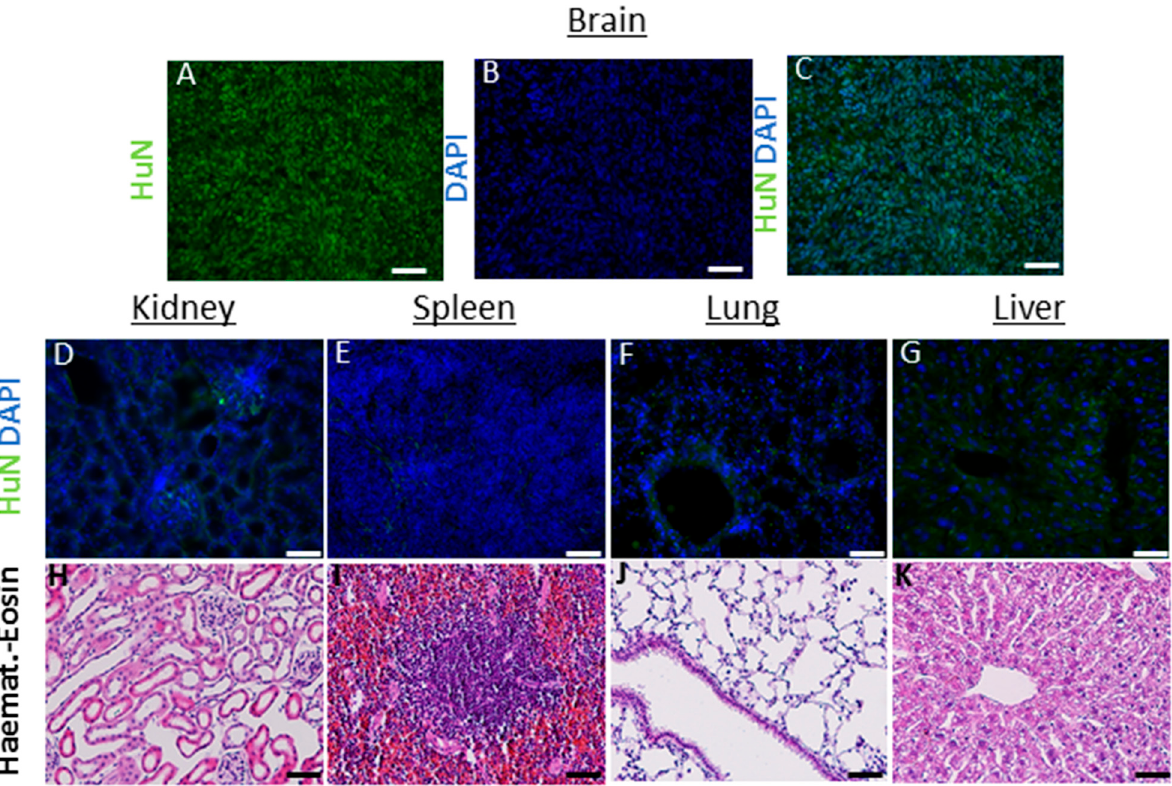
Figure 3. ( A – M ) Analysis in nontarget organs: the antibody huN, which selectively recognizes only the nucleus of human cells, was used to detect the presence of transplanted hNSCs, within the parenchyma of mouse organs outside the brain (6 months after transplant). Brain sections containing human cancer neural stem cells ( A – C ) were used as positive controls to assess the correct functioning of the antibody and immunofluorescence protocol. No cells were detected in kidney ( D ), spleen ( E ) lungs ( F ) and liver ( G ) and lymph nodes (not shown). As additional safety evaluation, hematoxylin eosin was used to assess the preservation of the parenchyma, the absence of inflammatory processes (edema, blood-born immune cells infiltration) or signs of de novo tumorigenesis ( H – K ). Scale bars: ( D – G ) 50 µm. ( H – K ) 100 µM .